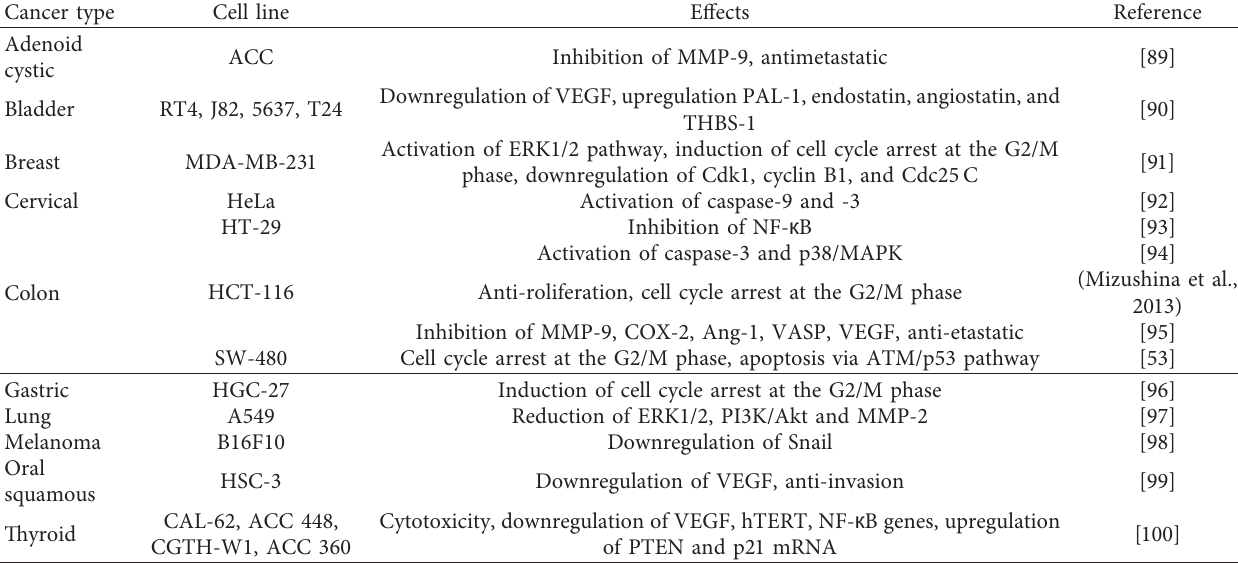
Table 3: The anticancer effects of genistein on different cell